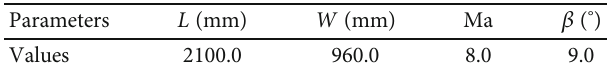
Figure 3: Control curves of an OCD waverider on the base plane. Table 1: Design parameters of the compression surface of sharp